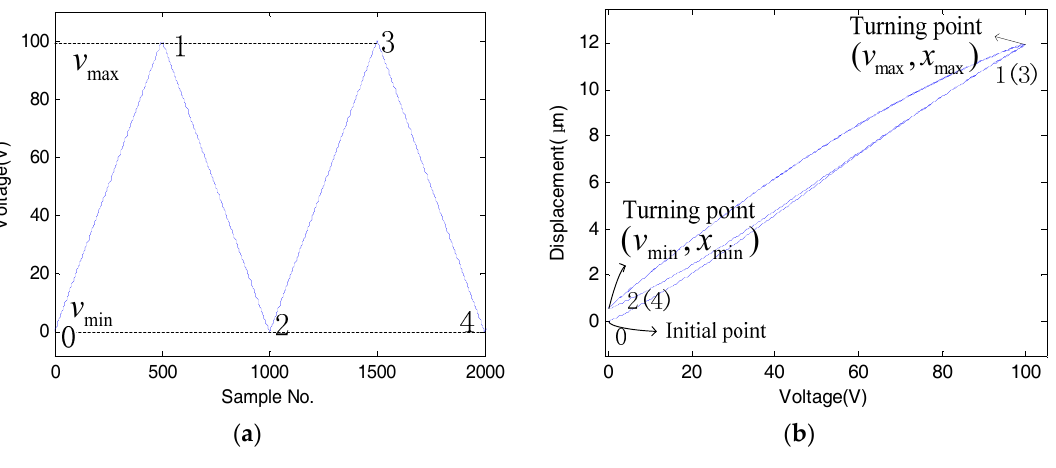
Figure 4. The hysteresis response. ( a ) The input triangular signals; ( b ) the corresponding hysteresis response.